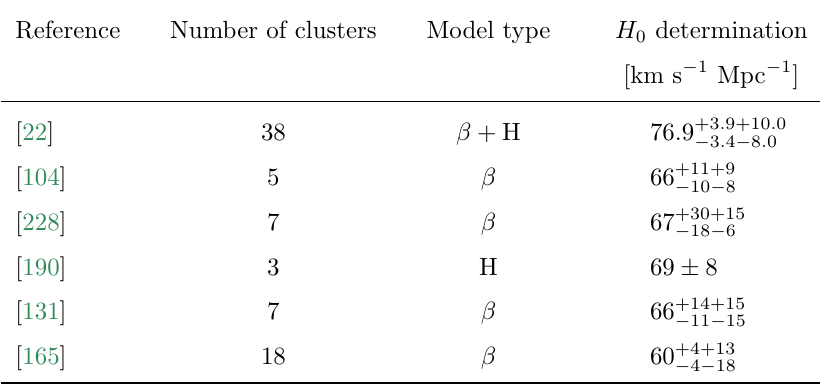
Table 2: Some recent measurements of 𝐻 0 using the S-Z effect. Model types are 𝛽 for the assumption of a 𝛽 -model and H for a hydrostatic equilibrium model. Some of the studies target the same clusters, with three objects being common to more than one of the four smaller studies, The larger study [22] contains four of the objects from [104] and two from